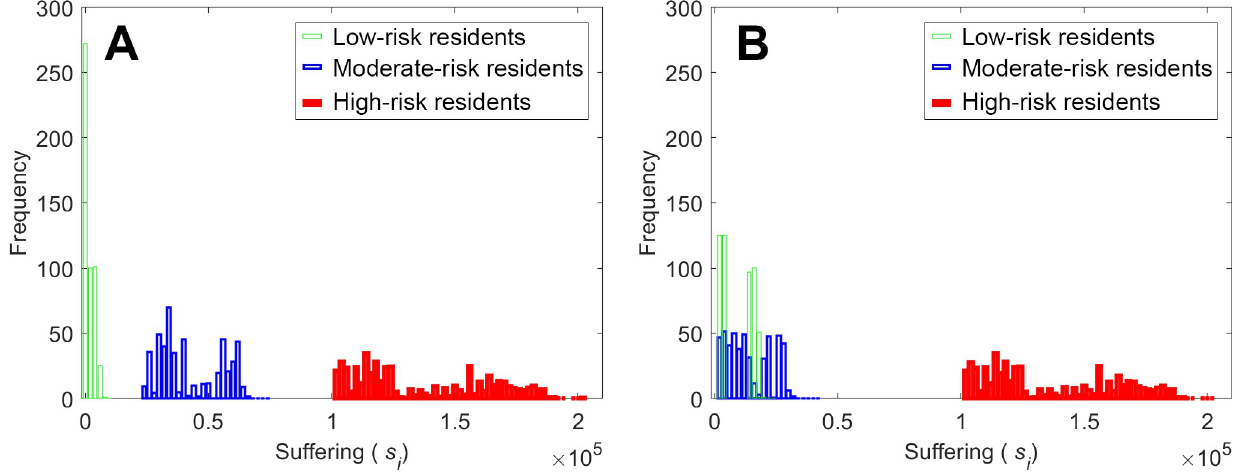
Fig 5. Distributions of the suffering levels for 1500 residents under the different zone sequences: (A) LMH strategy and (B) MLH strategy. Two cases are compared under a time delay of 1000 and a moderately nonuniform shelter capacity. The color represents the different zones divided in staged evacuation.